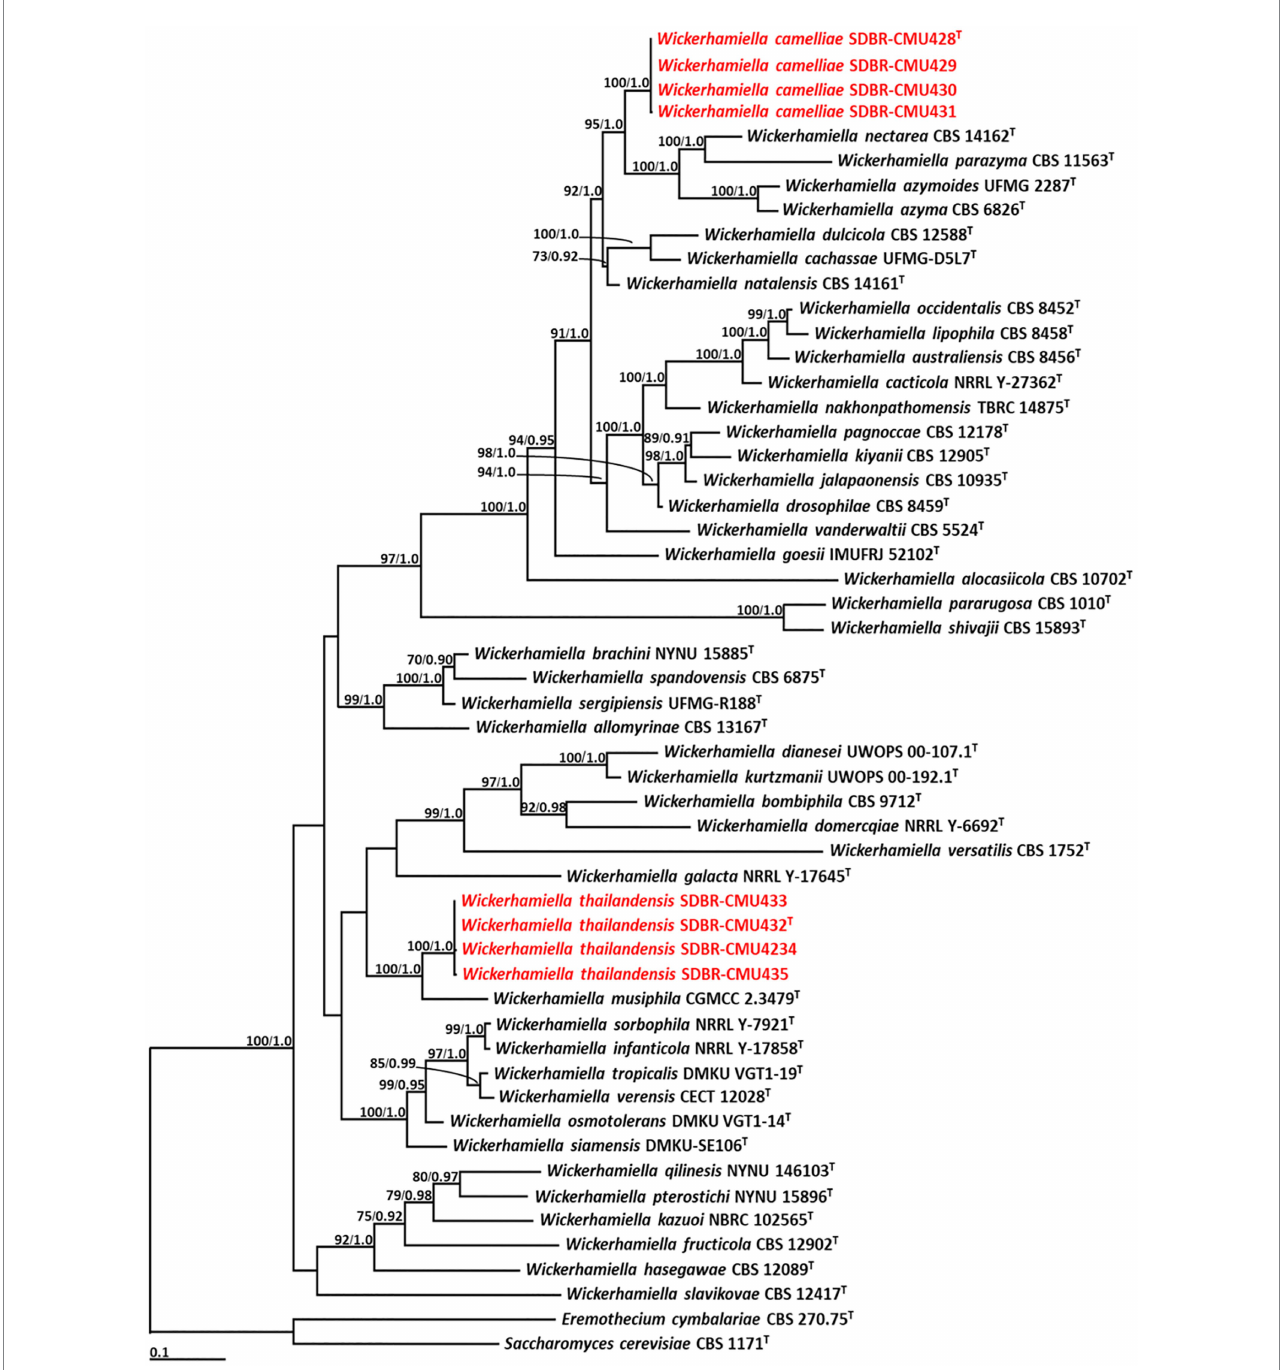
FIGURE 3 Phylogram derived from maximum likelihood analysis of 52 combined sequences of ITS region and D1/D2 domain of Wickerhamiella strains. Eremothecium cymbalariae CBS 1171 and Saccharomyces cerevisiae CBS 270.75 were used as the outgroup. The numbers above branches represent bootstrap percentages (left) and Bayesian posterior probabilities (right). Bootstrap values >70% and Bayesian posterior probabilities >0.90 are shown. The scale bar represents the expected number of nucleotide substitutions per site. Sequences obtained from this study are in red. Type species indicated by superscript